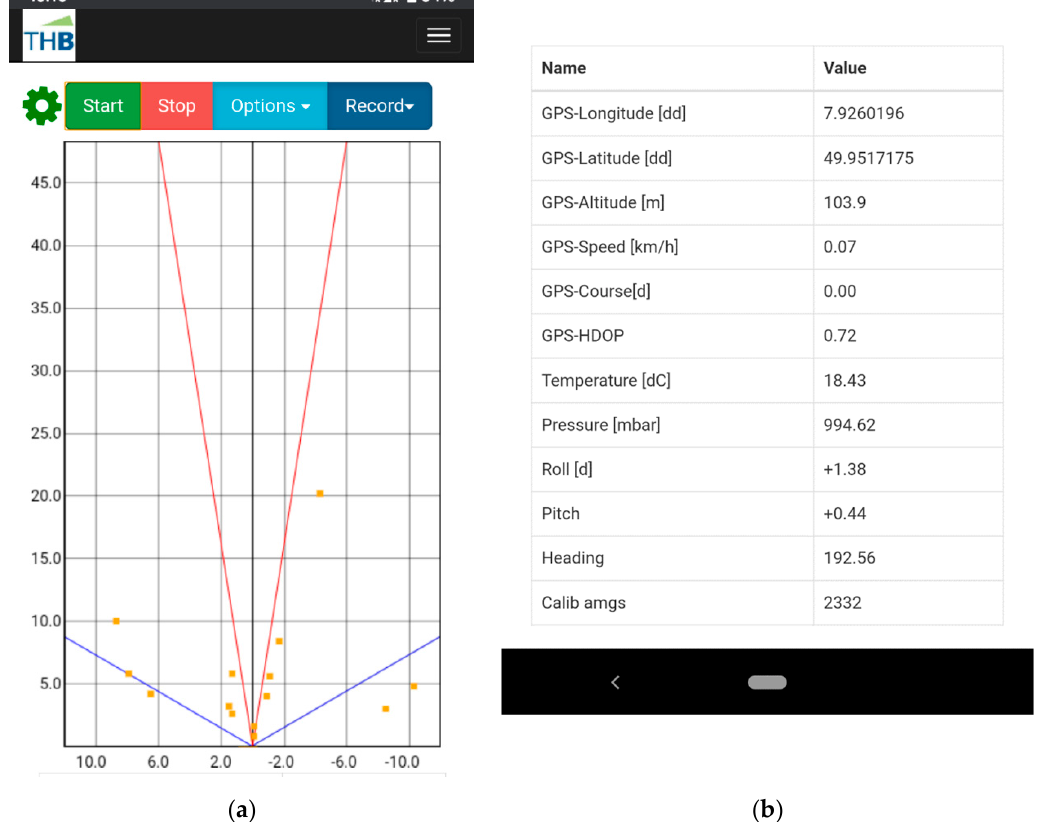
Figure 3 . Screenshots obtained from a smartphone with the website aiming to show the live view of the radar data and a table of sensor data. ( a ) Some clusters are shown as orange points in the coordinate system. The buttons on the upper side are used to control the system. ( b ) By scrolling down the website, a table shows the most important sensor data.